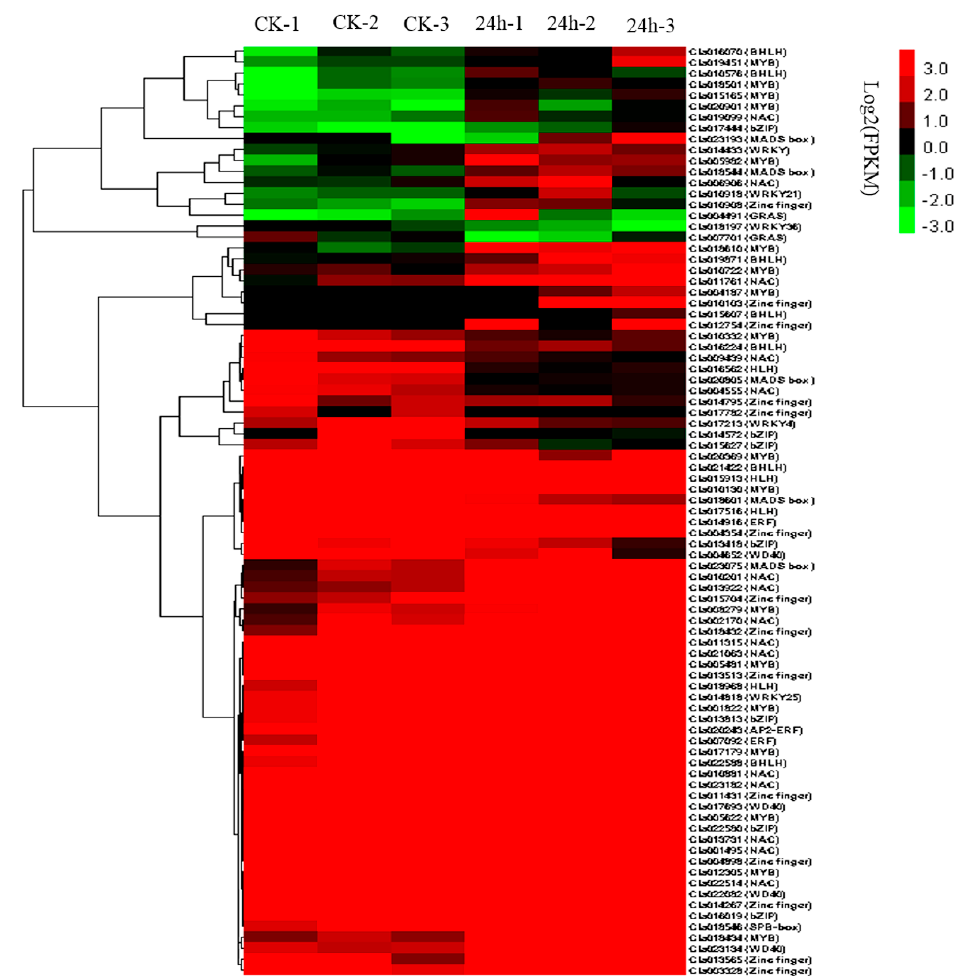
Figure 6. Transcription factors involved in responses to CGMMV infection in watermelon leaves.